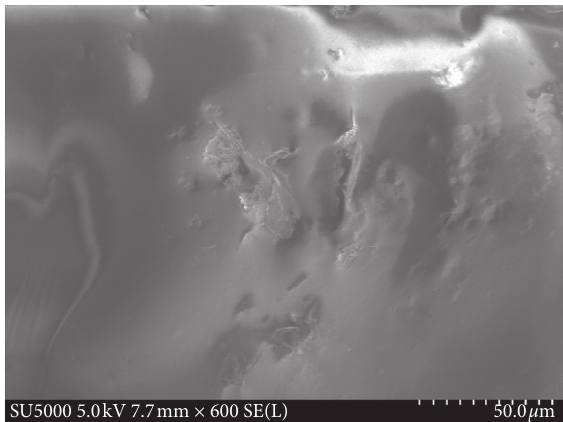
Figure 4: RMMAFC by electron microscopy. Figure 3: RMMA by electron